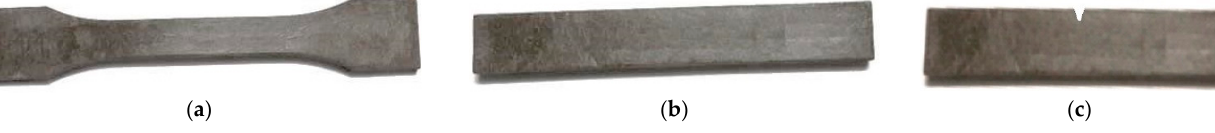
Figure 1. Samples for: ( a ) tensile; ( b ) bending; ( c ) impact test.